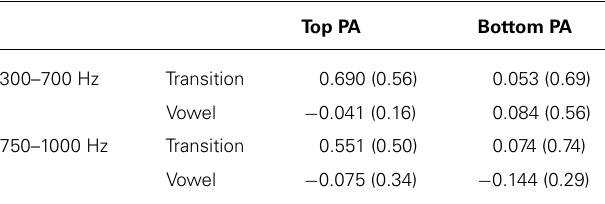
Table 2 | Mean phase distinctions for the two frequency ranges are reported for each group (in rad, with SDs). Top PA Bottom